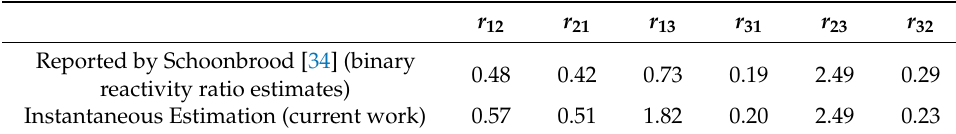
Table 6. Reactivity ratio estimates for the terpolymerization of styrene (Sty) / MMA / methyl acrylate (MA). Experimental data from [34].